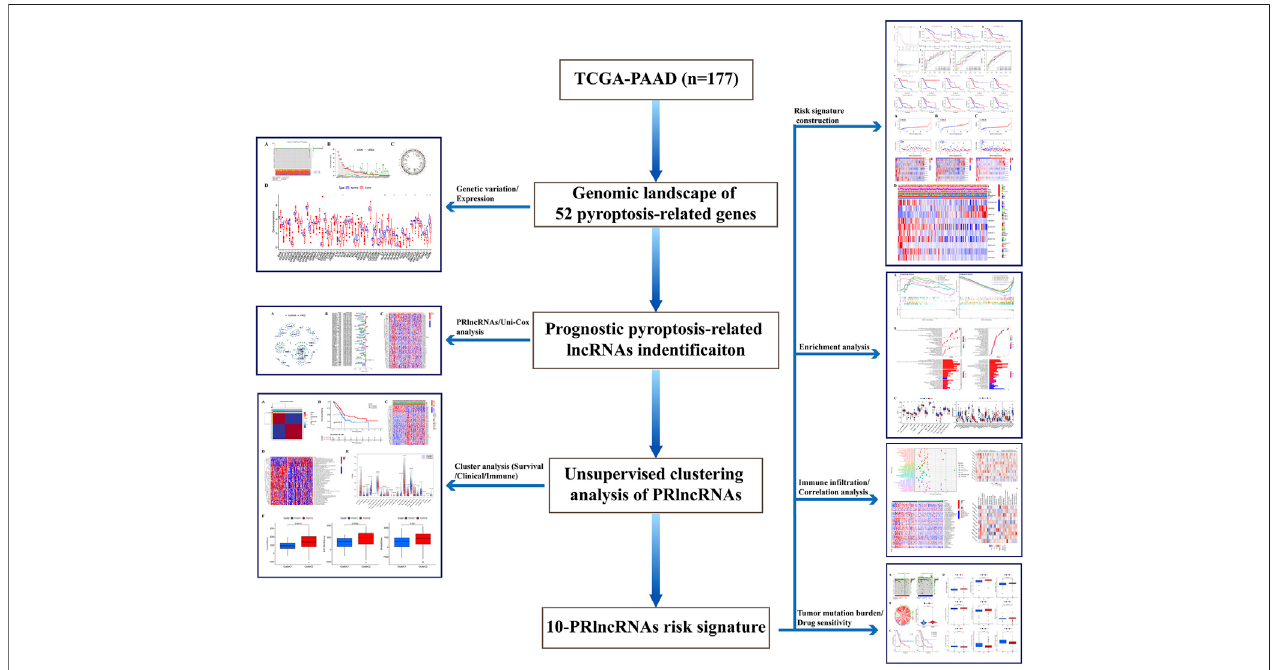
FIGURE 1 | Flow chart of this